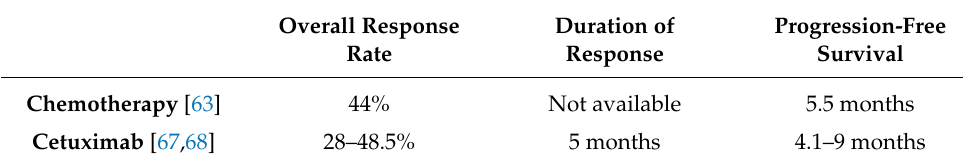
Table 7. Summary of results with chemotherapy and cetuximab for the treatment of advanced cutaneous squamous cell carcinoma (CSCC). Overall Response Duration of Response